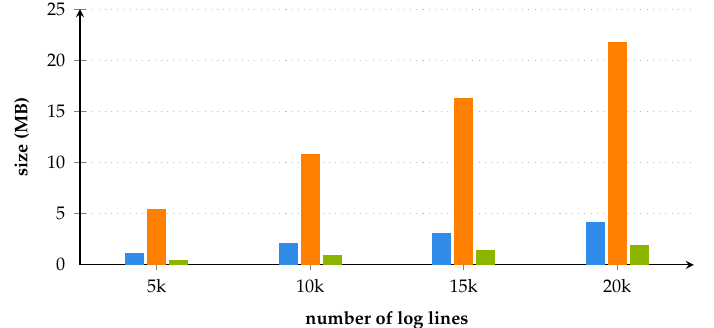
Figure 13. Graph compression